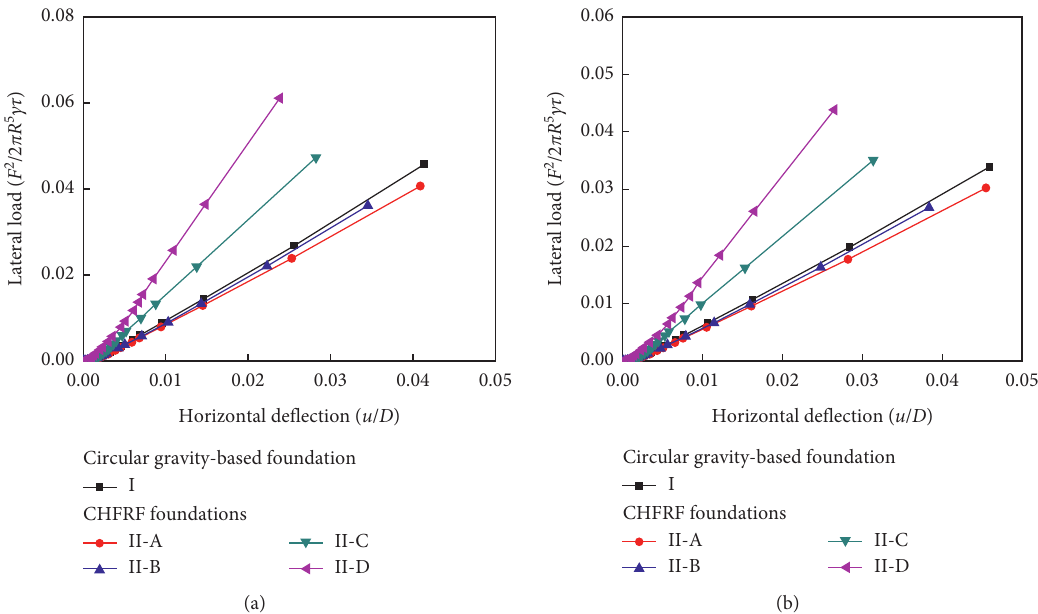
Figure 6: Relationship between lateral load and horizontal deflection ( d / D � 0). (a) e � 22.5 cm.(b) e � 37.5cm.